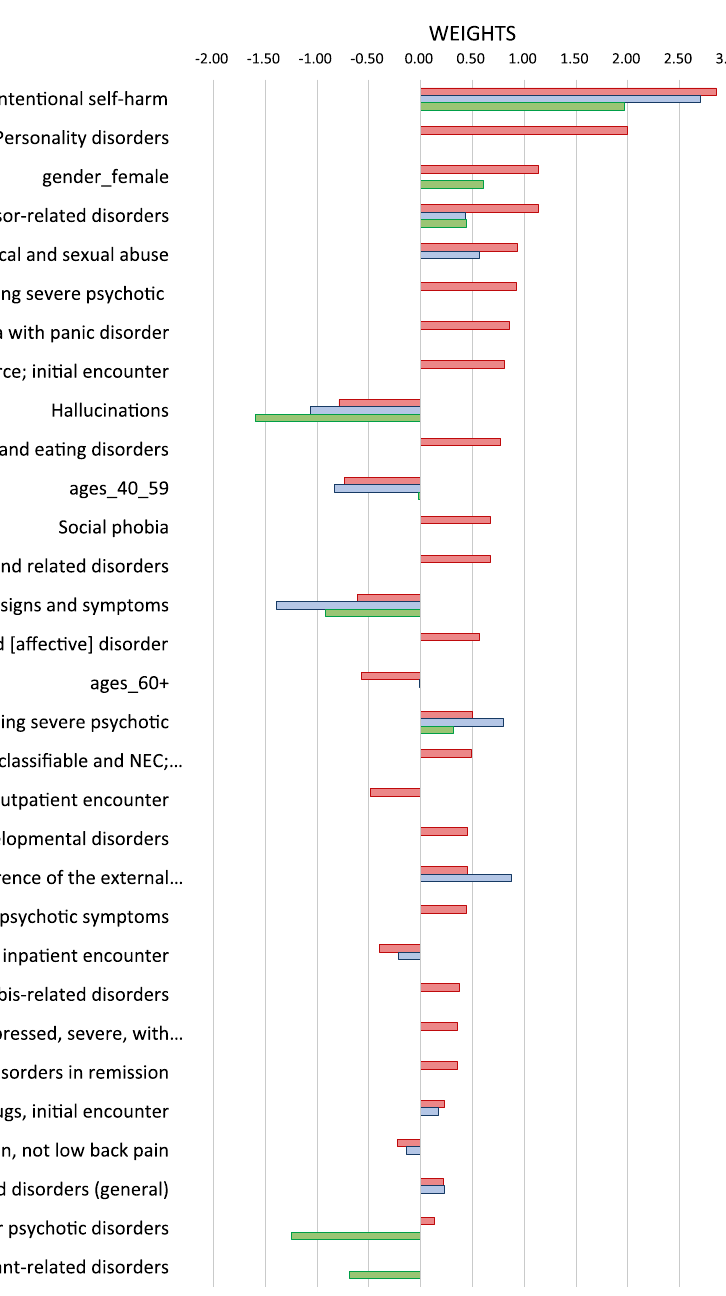
Figure 4. Important features and their weights in the models trained on silver-label data (main model), gold- label data (initial model), and subset of gold-label data (adjustment model). Missing bars represent zero weights, namely no contribution, of corresponding features to the final predictive